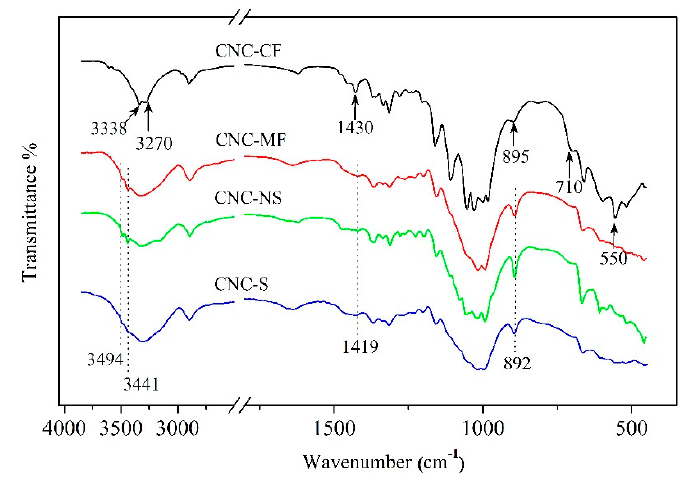
Figure 6. FTIR spectra of CNC isolated from cotton linter (CNC-CF and CNC-MF) and from Cynara scolymus L (CNC-NS and CNC-S).